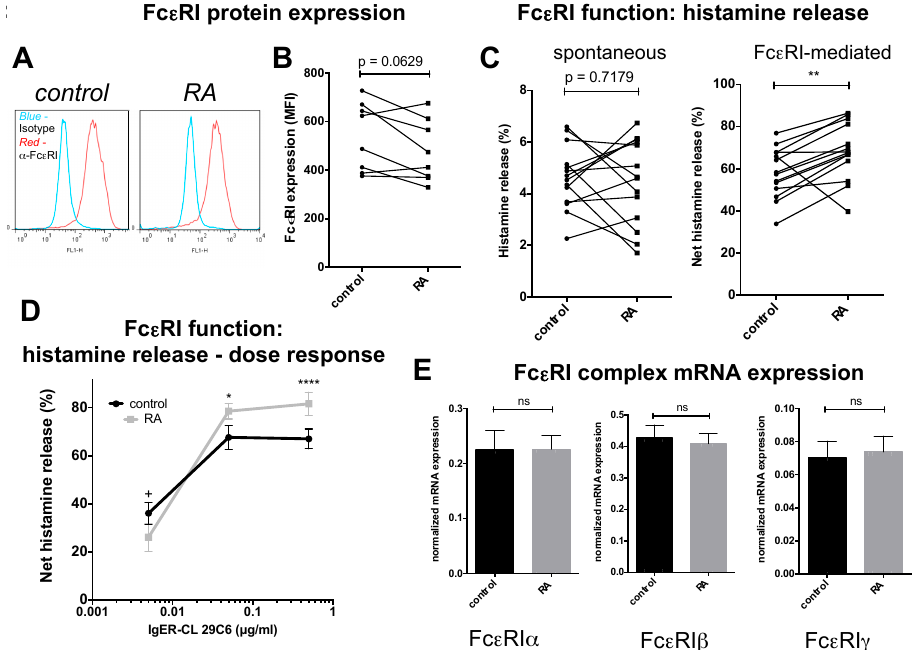
Fig 3 Fc  RI protein expression Fc  RI function: histamine release